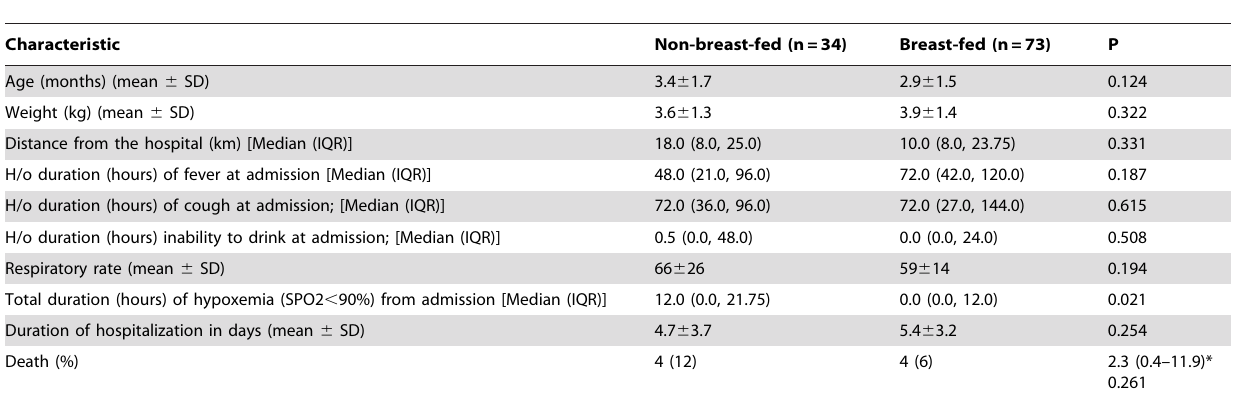
Table 1. Comparison of characteristics of breast-fed and non-breast-fed infants with pneumonia and diarrhea.